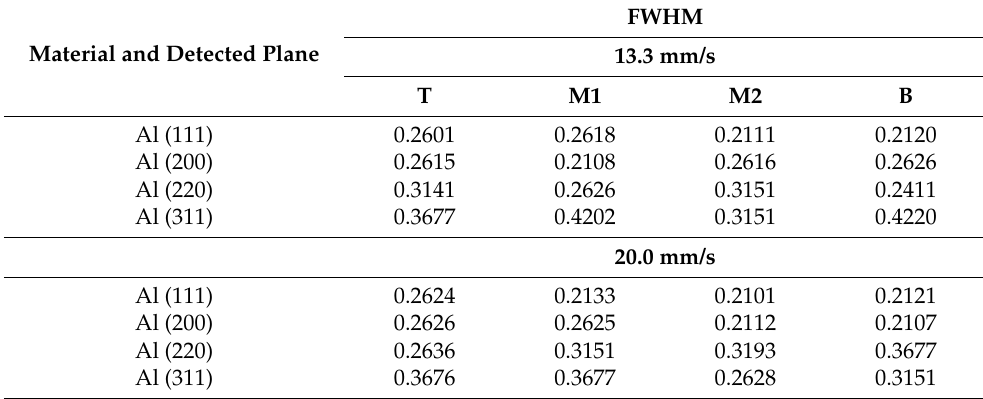
Table 3. Full width at half maximum (FWHM) of the detected